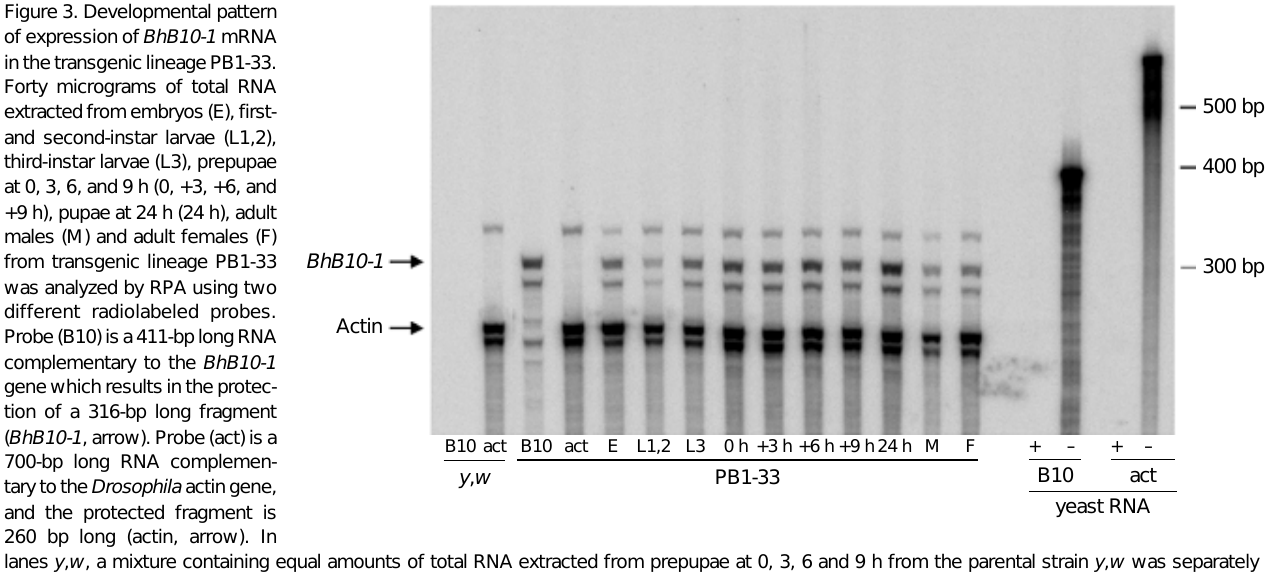
Figure 3. Developmental pattern of expression of BhB10-1